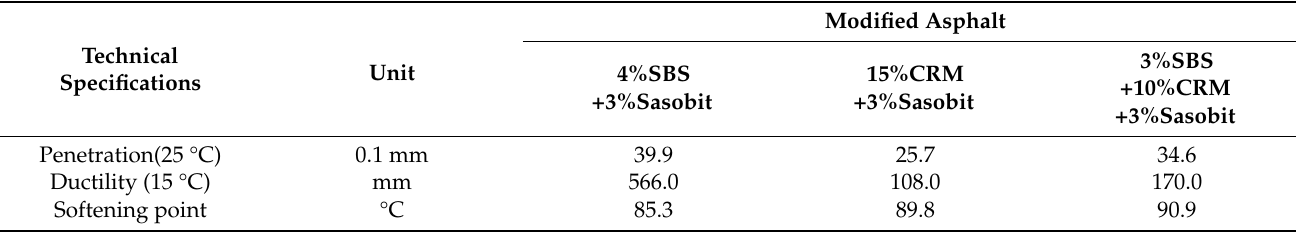
Table 6. Modified asphalt conventional technical